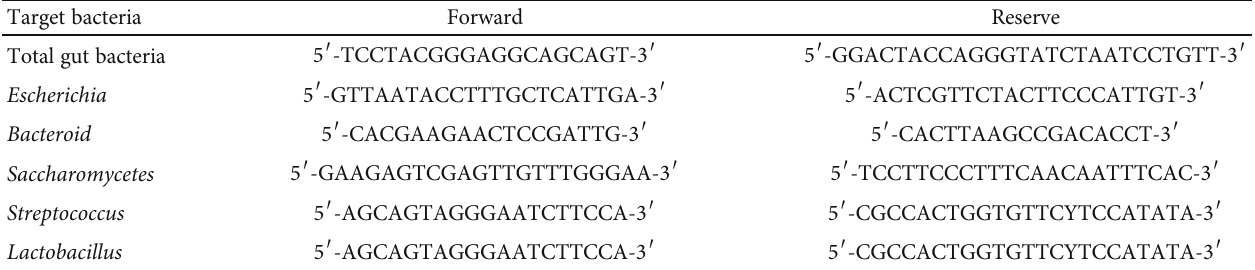
Table 1: Primers for